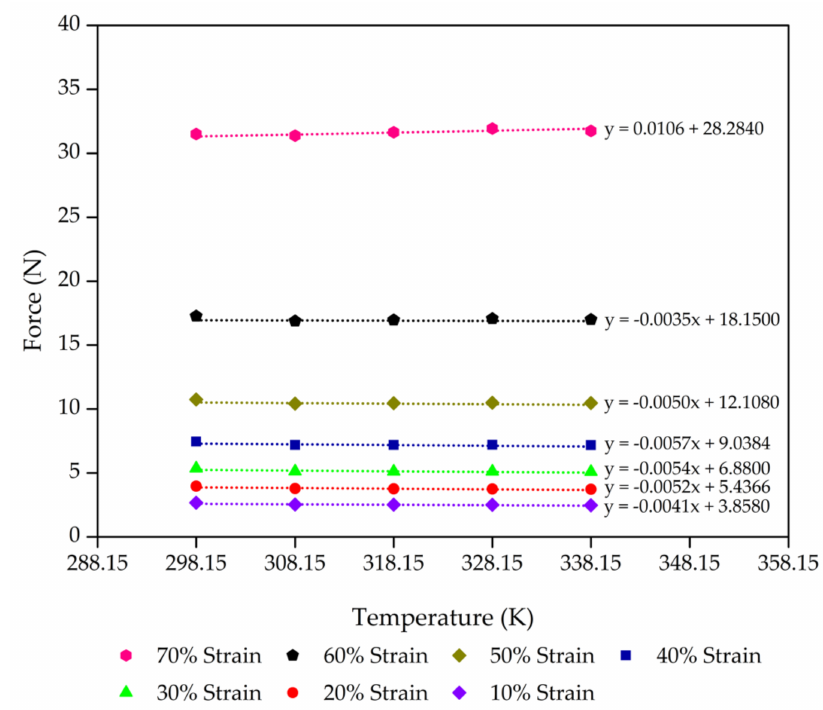
Figure 6. Compression force as a function of the temperature of the control - 30% Po sample from 10% to 70% compression strain with a minimum linear regression (R 2 ) = 0.9 at each strain. The scatter on the results is on the order of the size of the data points.